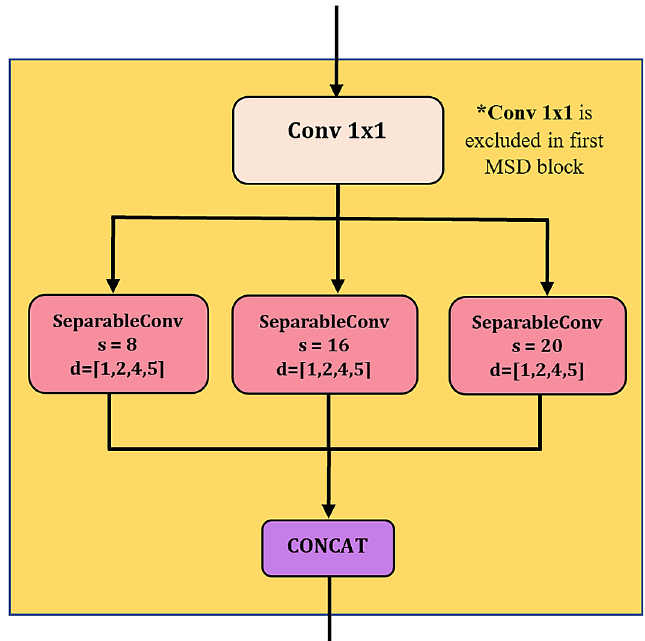
Figure 3. Convolutional unit in MSD block. (concat = concatenation, conv = convolution, s = kernel size and d = dilation rate).